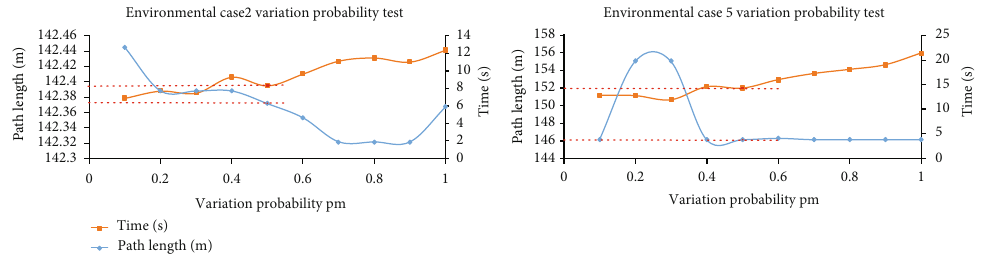
Figure 13: In fl uence of parameter pm on path length and time.